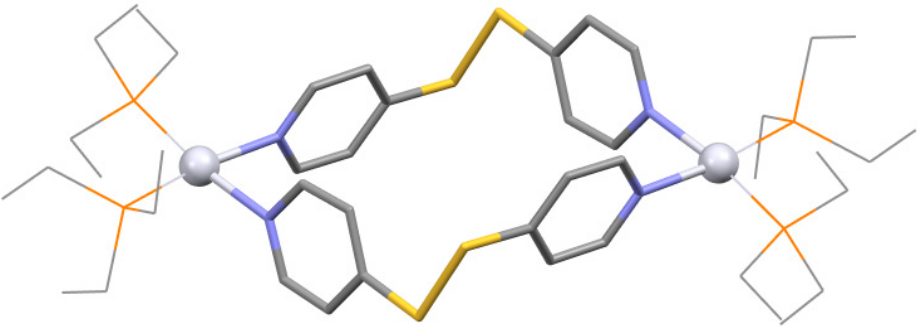
](NO ) ·4CH OH (XIWNEW). 2 3 4 3